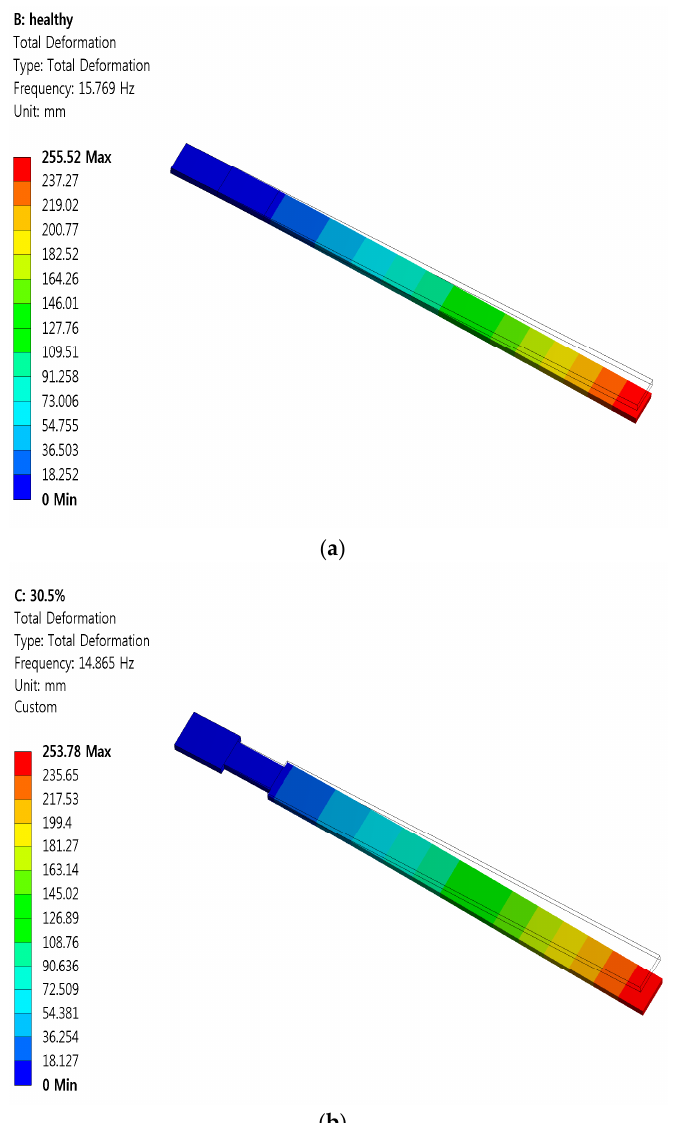
Figure 9. ANSYS analysis examples for the first natural frequencies of the beam; ( a ) healthy beam case and ( b ) 30.5% damaged case.